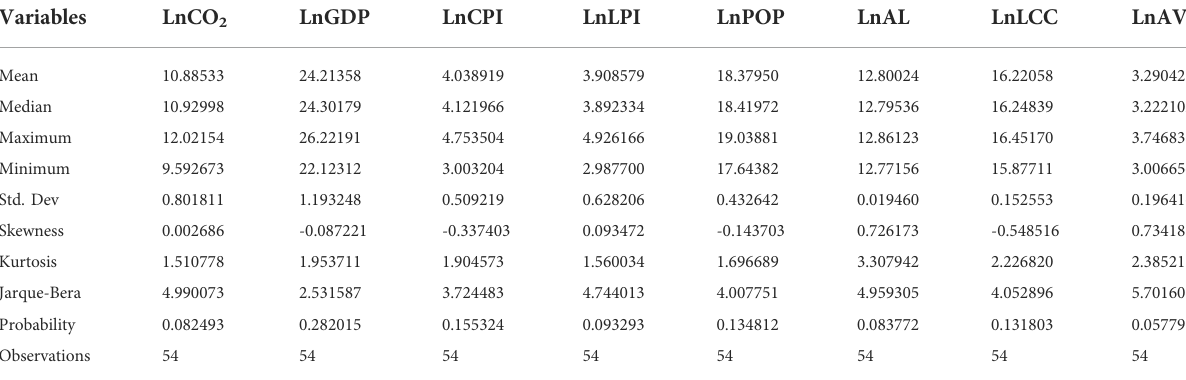
TABLE 2 Descriptive statistics analysis for all variables.